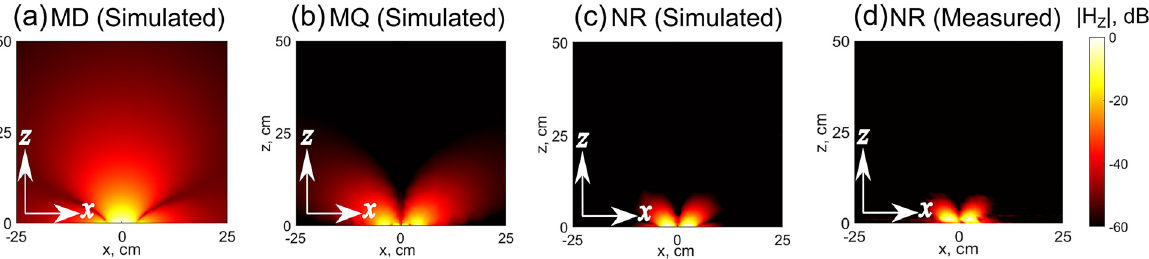
Figure 4: Simulated normal component of the magnetic field distribution at x – z plane perpendicular to the dielectric disk surface on (a) MD, (b) MQ, and (c) NR modes. (d) Measured normal component of the magnetic field distribution corresponding to NR resonance at the frequency 408.6 MHz. The simulated fields magnitudes are normalized to MD maximum on the panel (a) and the measured field values on NR resonance is normalized to itself maximum